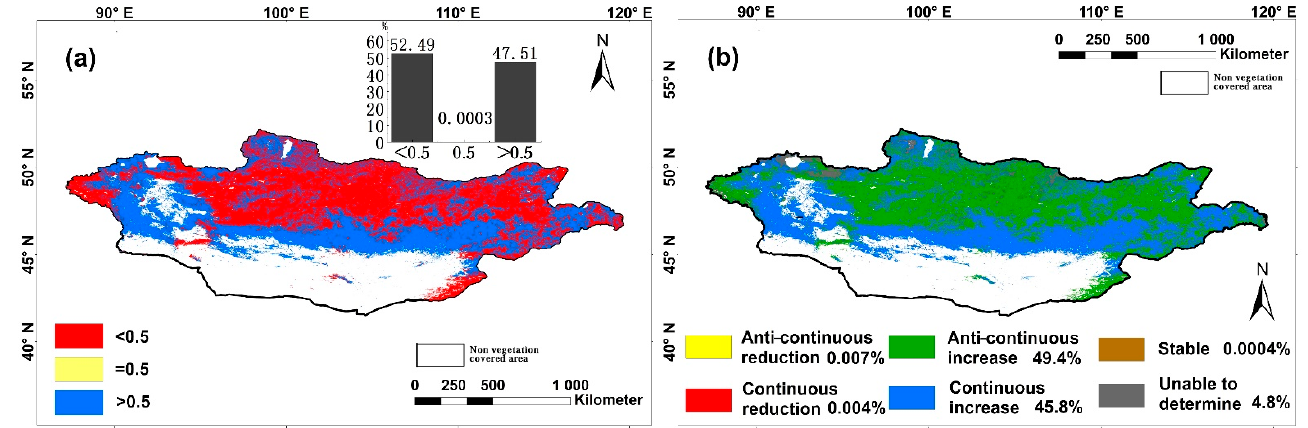
Figure 4. Spatial distributions of the Hurst index and future NDVI trends in Mongolia during 2001– 2020: ( a ) Hurst index and ( b ) future NDVI trends. 2001–2020: ( a ) Hurst index and ( b ) future NDVI